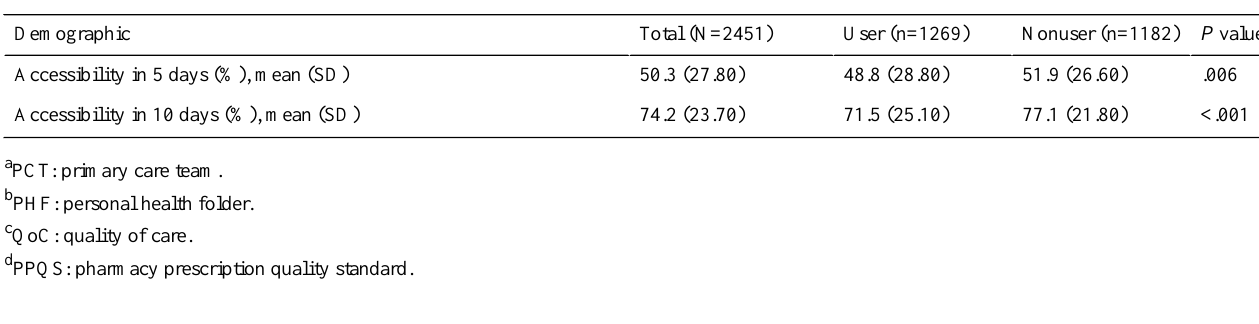
Table 3. Results of the logistic regression model.